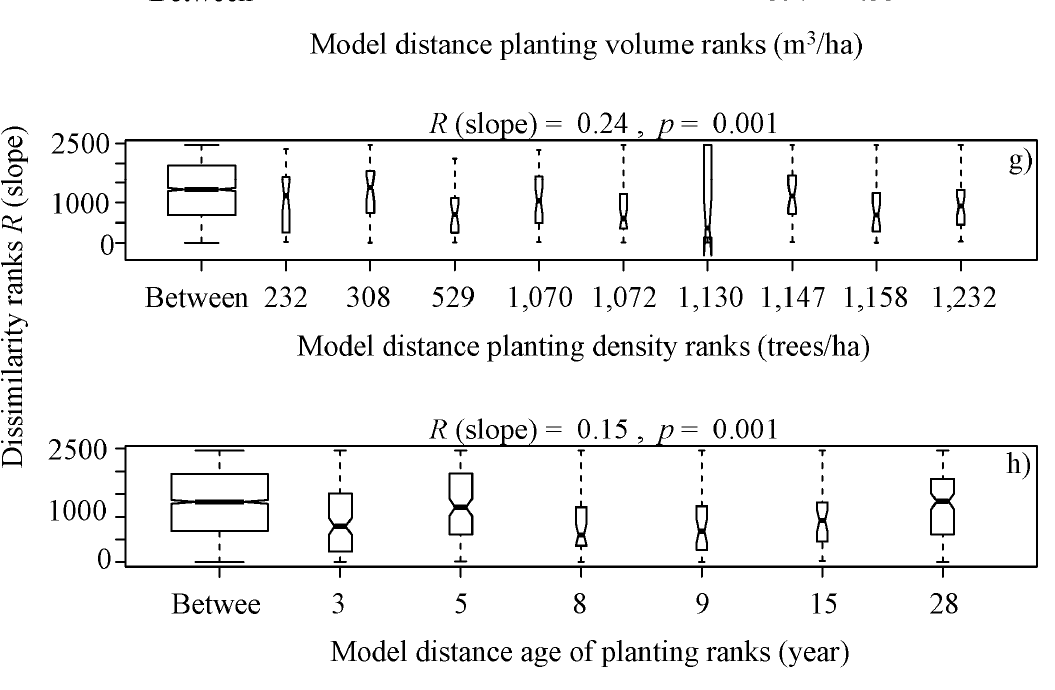
Figure 4. Box plot of rank dissimilarities ( R (slope)) among the 9 sites against native forest area ranks ( a ), plantation area ranks ( b ), harvested area ranks ( c ), canopy openness ranks ( d ), solar radiation transmitted ranks ( e ), planting volume ranks ( f ), planting density ranks ( g ) and age of planting ranks ( h ), from a serial ordering model of groups.